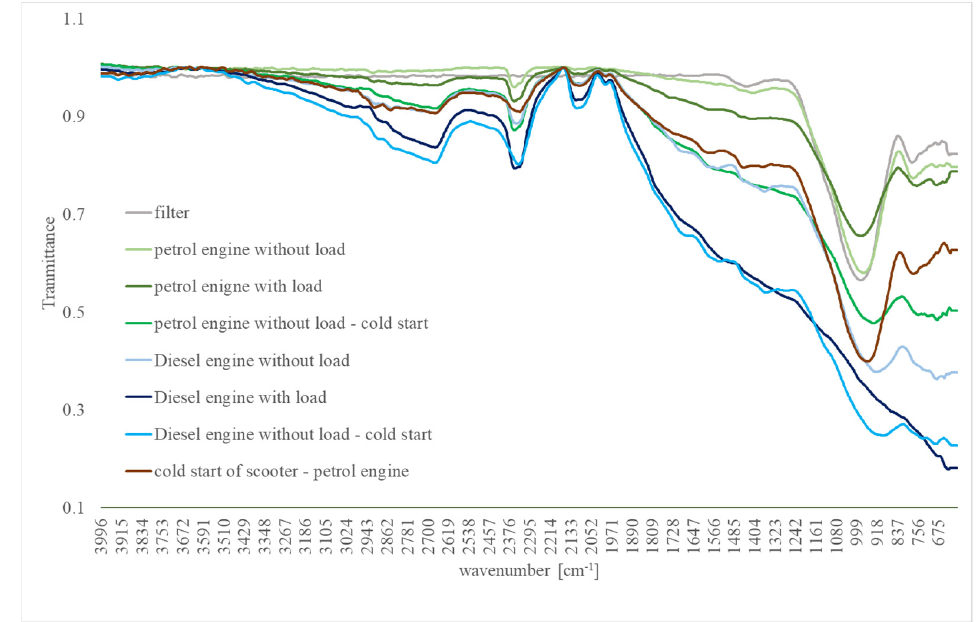
Figure 7. FTIR ATR spectra of PM adsorbed on filter from Diesel and petrol engine. All adsorbed PMs collected from both engines (Diesel and petrol) possess carbon black: a baseline sloping down to the right (%T display) as carbon black displays absorp- tion over the entire region from 4000 to 400 cm − 1 , and, when using the ATR technique, the effect of carbon black becomes greater, with deeper light penetration at the long wave- length (low wavenumber) end. The largest amount of carbon black is present at PMs emit- ted from Diesel engine, both working with and without load and during cold start.